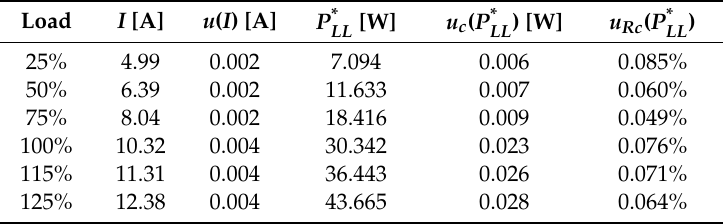
Table 5. Experimental results—additional losses with uncertainties according to [6].